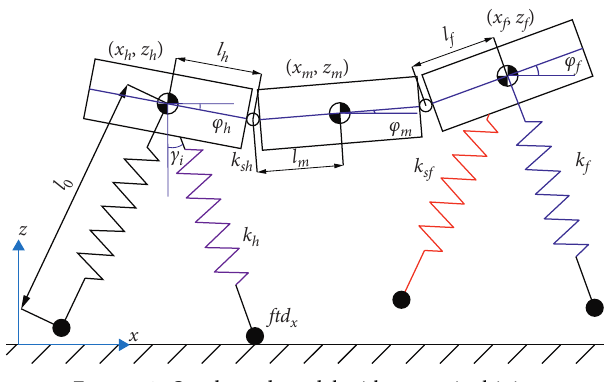
Figure 1: Quadruped model with two spinal